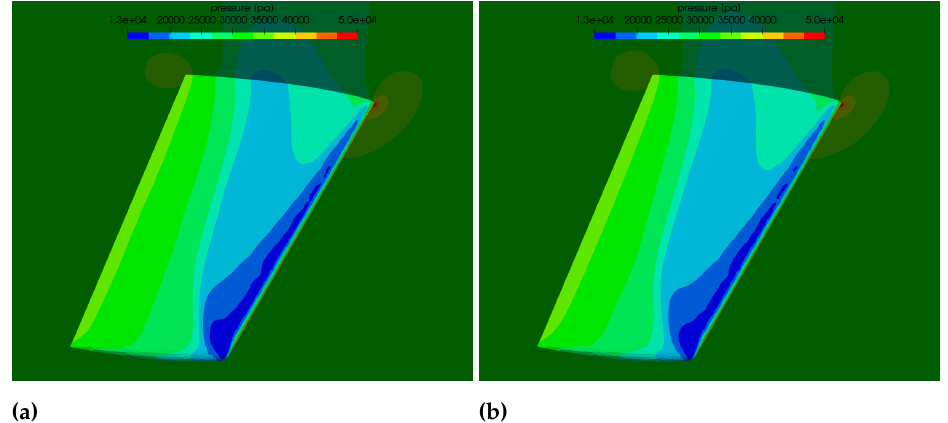
Figure 29. C p verses x / c at ( a ) y / b = 0.2 and ( b ) y / b = 0.9.